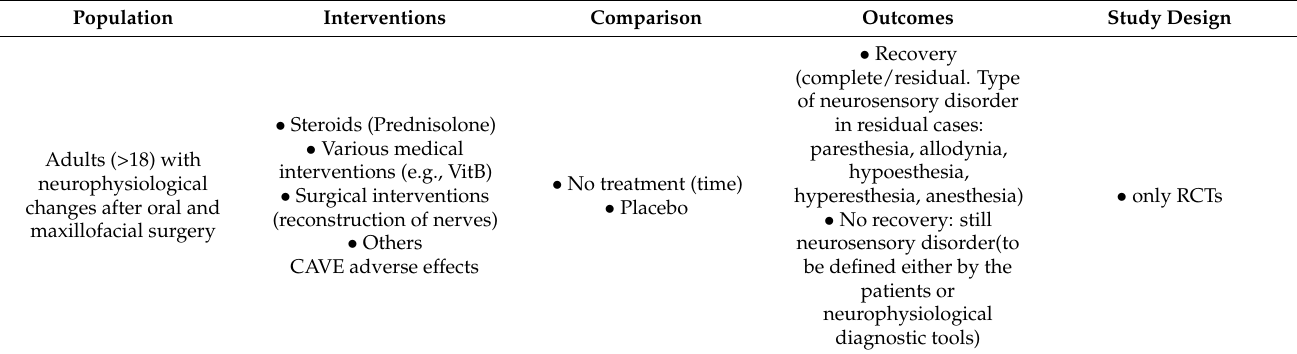
Table 1. Definition of PICO (Population/Interventions/Comparisons/Outcome). Population Interventions Comparison Outcomes Study Design